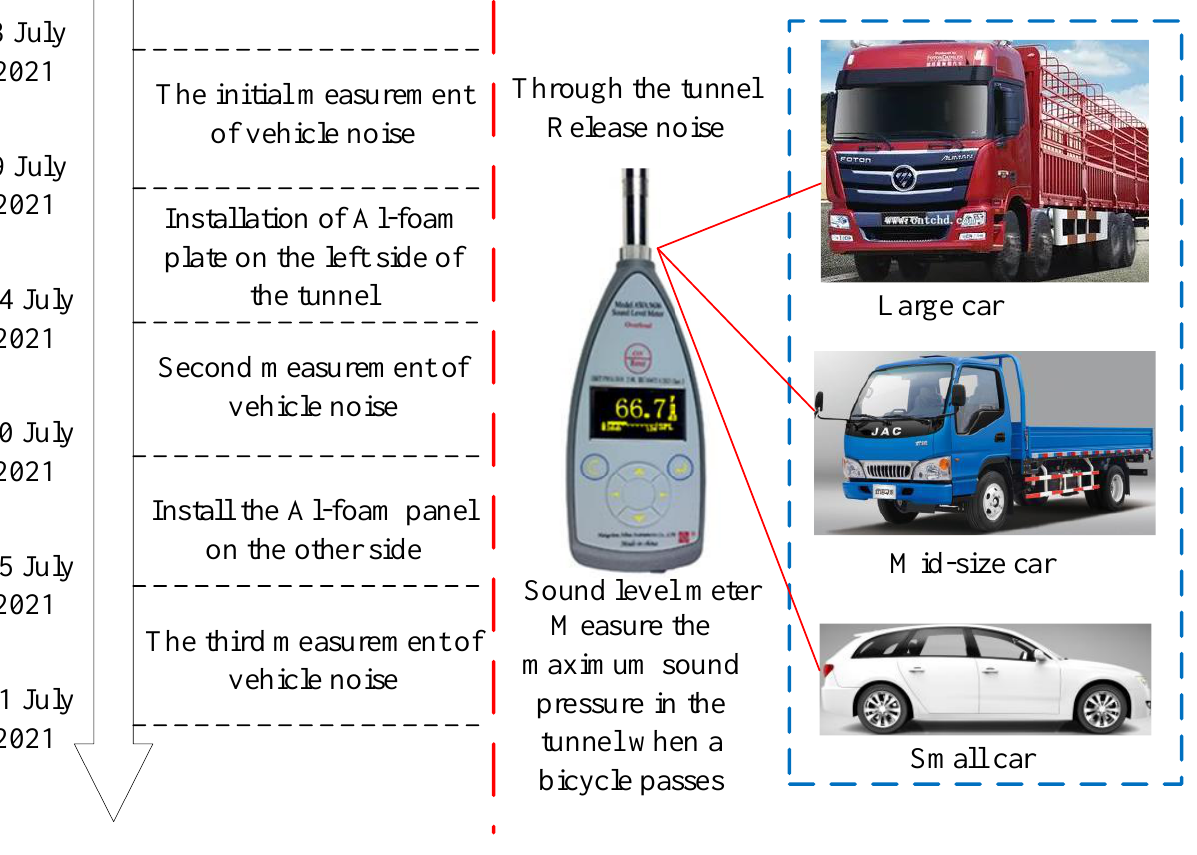
Figure 8. Test flow chart of Case II.